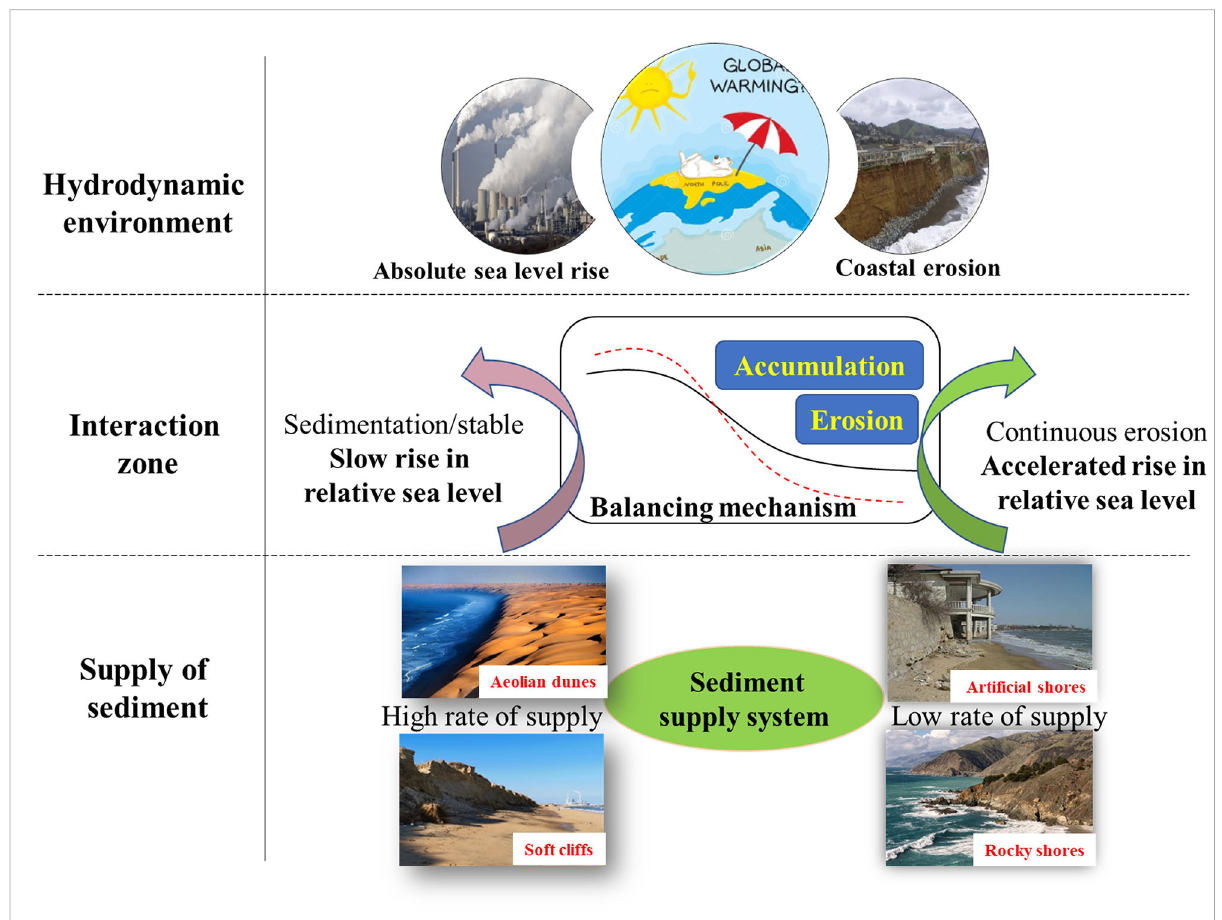
FIGURE 10 Balancing between the supply of sediment and hydrodynamic environment in the coastal